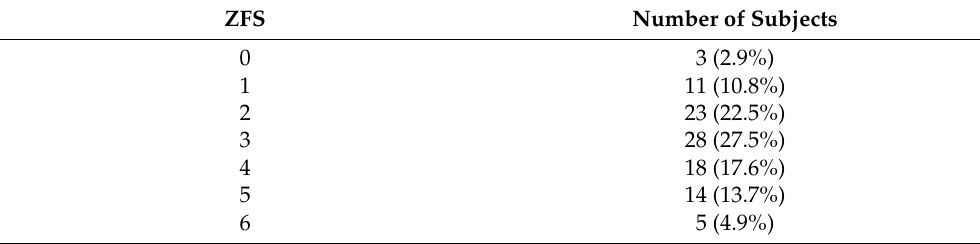
Table 7. Zulfiqar Frailty Scale (ZFS) score distribution (n = 102).